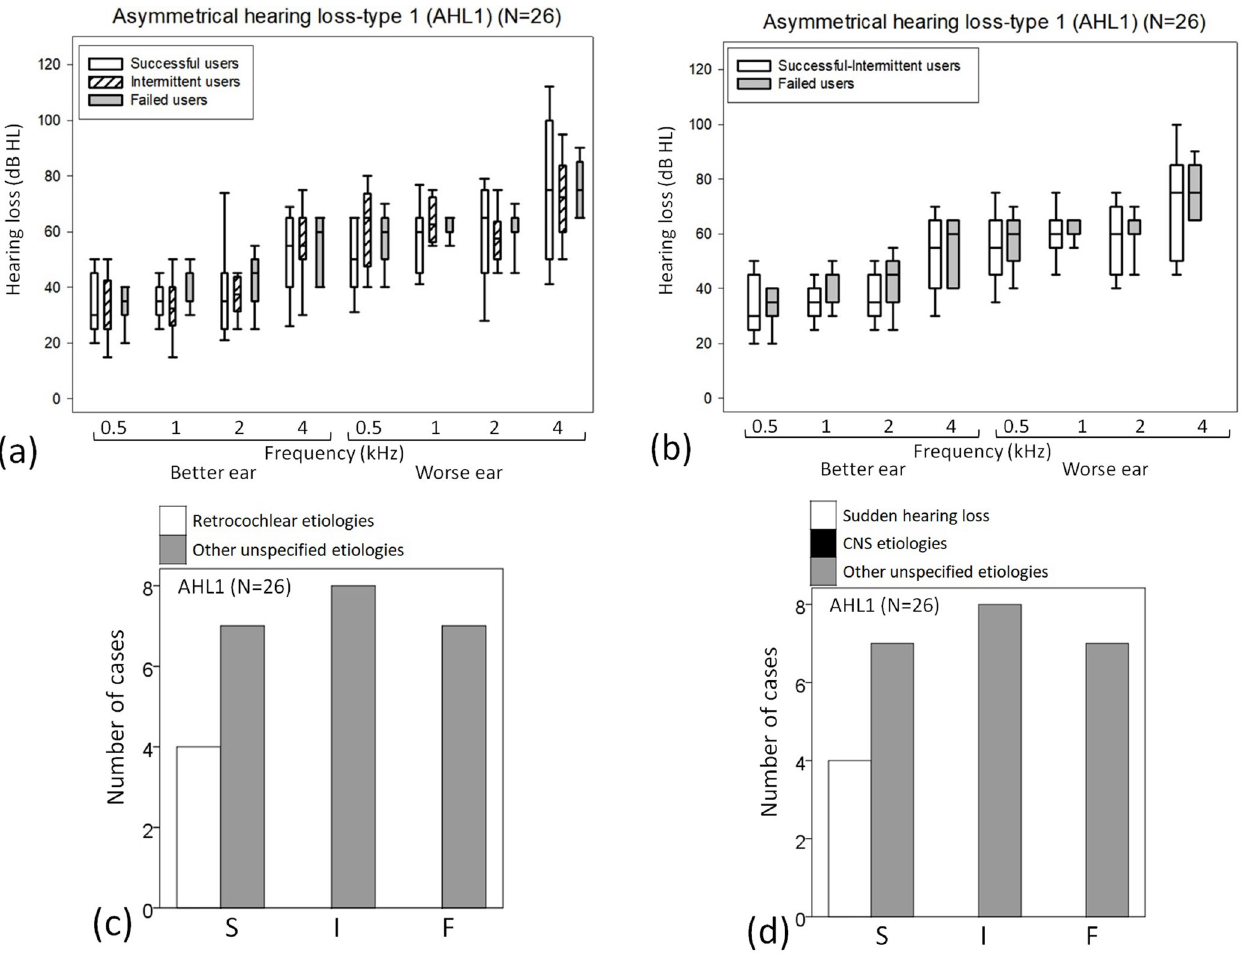
Figure 3. ( a – d ) In the AHL1 subgroup (n = 26), box plots of differences in the hearing thresholds according to ( a ) three and ( b ) two outcomes. Comparison by the etiology of hearing loss according to ( c , d ) three outcomes.